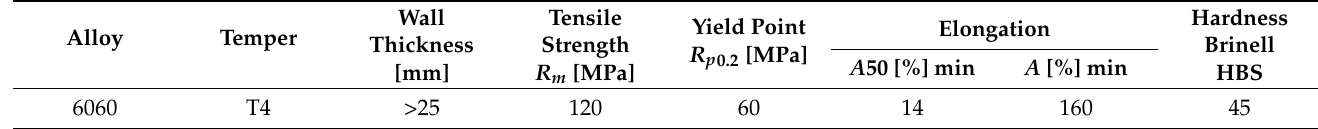
Table 2. Mechanical properties of the aluminum alloy 6060 T4 in accordance with PN-EN 755-2:2016-05 [30].